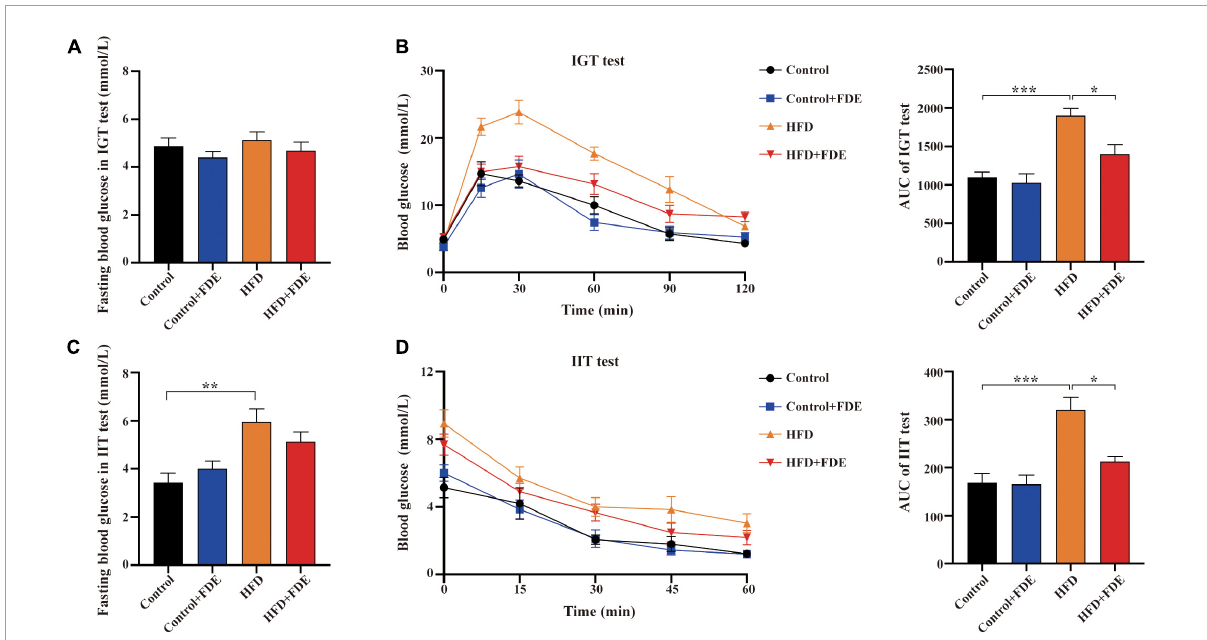
FIGURE3 Effect of FDE on improving insulin resistance and glucose tolerance in HFD-fed mice. (A) Mean fasting blood glucose of each group after fasting for 16 h using the intraperitoneal glucose tolerance (IGT) test. (B) Left, IGT test performed on mice; right, the area under the curve (AUC) of IGT testing. (C) Mean fasting blood glucose of each group after fasting for 2 h in the intraperitoneal insulin tolerance (IIT) test. (D) Left, IIT test performed on mice; right, the AUC of IIT testing. The data were analyzed by one-way ANOVA. All values are presented as the means ± SEM, and n = 4–6 per group. Control, normal diet; HFD, high-fat diet; Control + FDE, a mixture of FDE and normal diet; HFD + FDE, a mixture of FDE and high-fat diet. * P < 0.05, ** P < 0.01, *** P < 0.001. HFD group versus the control group, HFD + FDE group versus the HFD